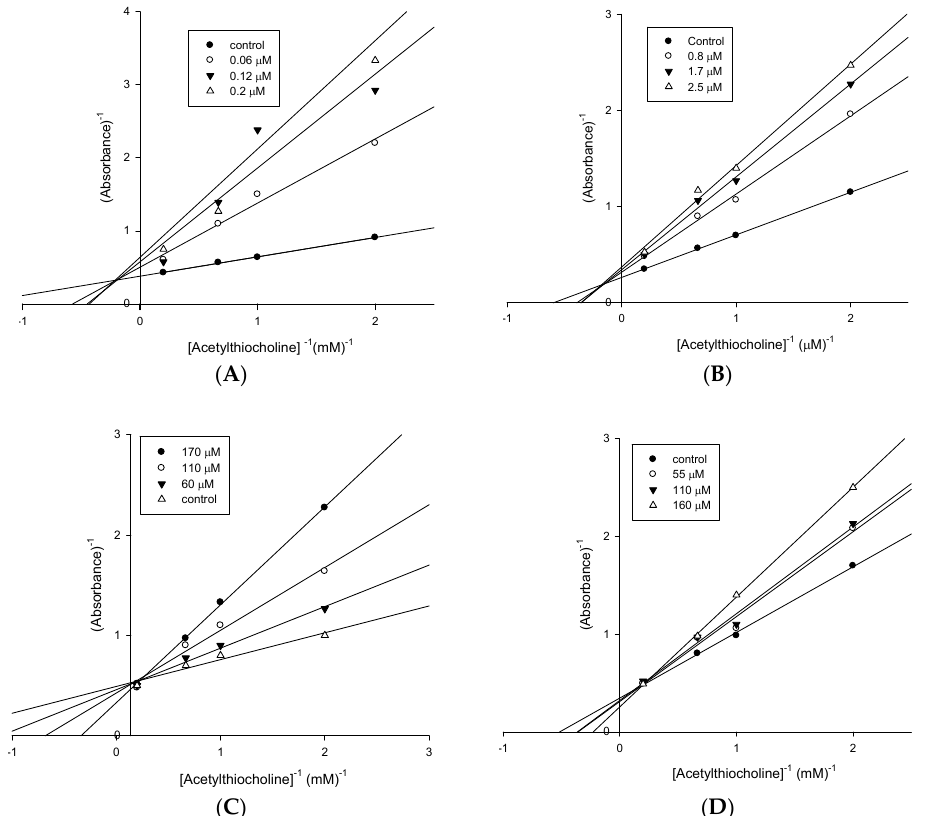
Figure 1. Lineweaver ‐ Burk plots for AChE inhibiton by ( A ) donepezil, ( B ) tacrine; ( C ) compound 3g and ( D ) compound 3h